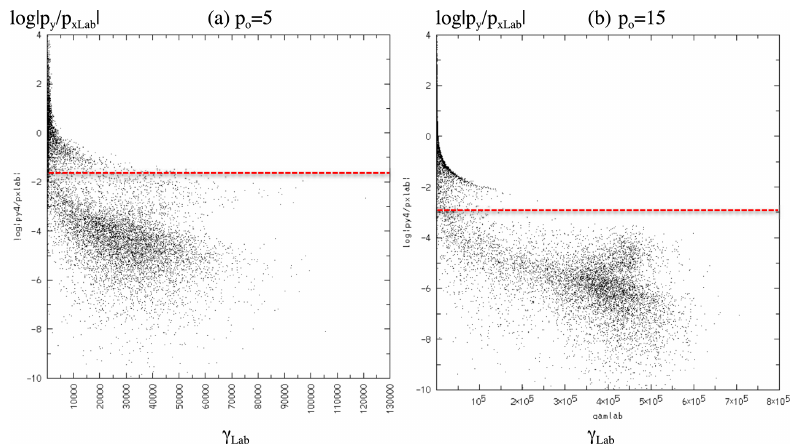
Figure 15. Anisotropic particle acceleration in relativistic shear layers from particle-in-cell simulations. Plotted is the log of the angle of the particles’ motion with respect to the jet axis, vs. particle energy, indicating that high-energy particles are beamed forward much more strongly than the standard 1/ Γ characteristic from relativistic aberration of an isotropic distribution (red dashed lines). p 0 = Γ cm β Γ ,cm is the dimensionless momentum in the center-of-momentum frame, in which spine and layer move with equal velocity β Γ ,cm c in opposite directions. ( a ) For p 0 = 5; ( b ) for p 0 = 15. From [134]. Reproduced with permission from the American Astronomical Society